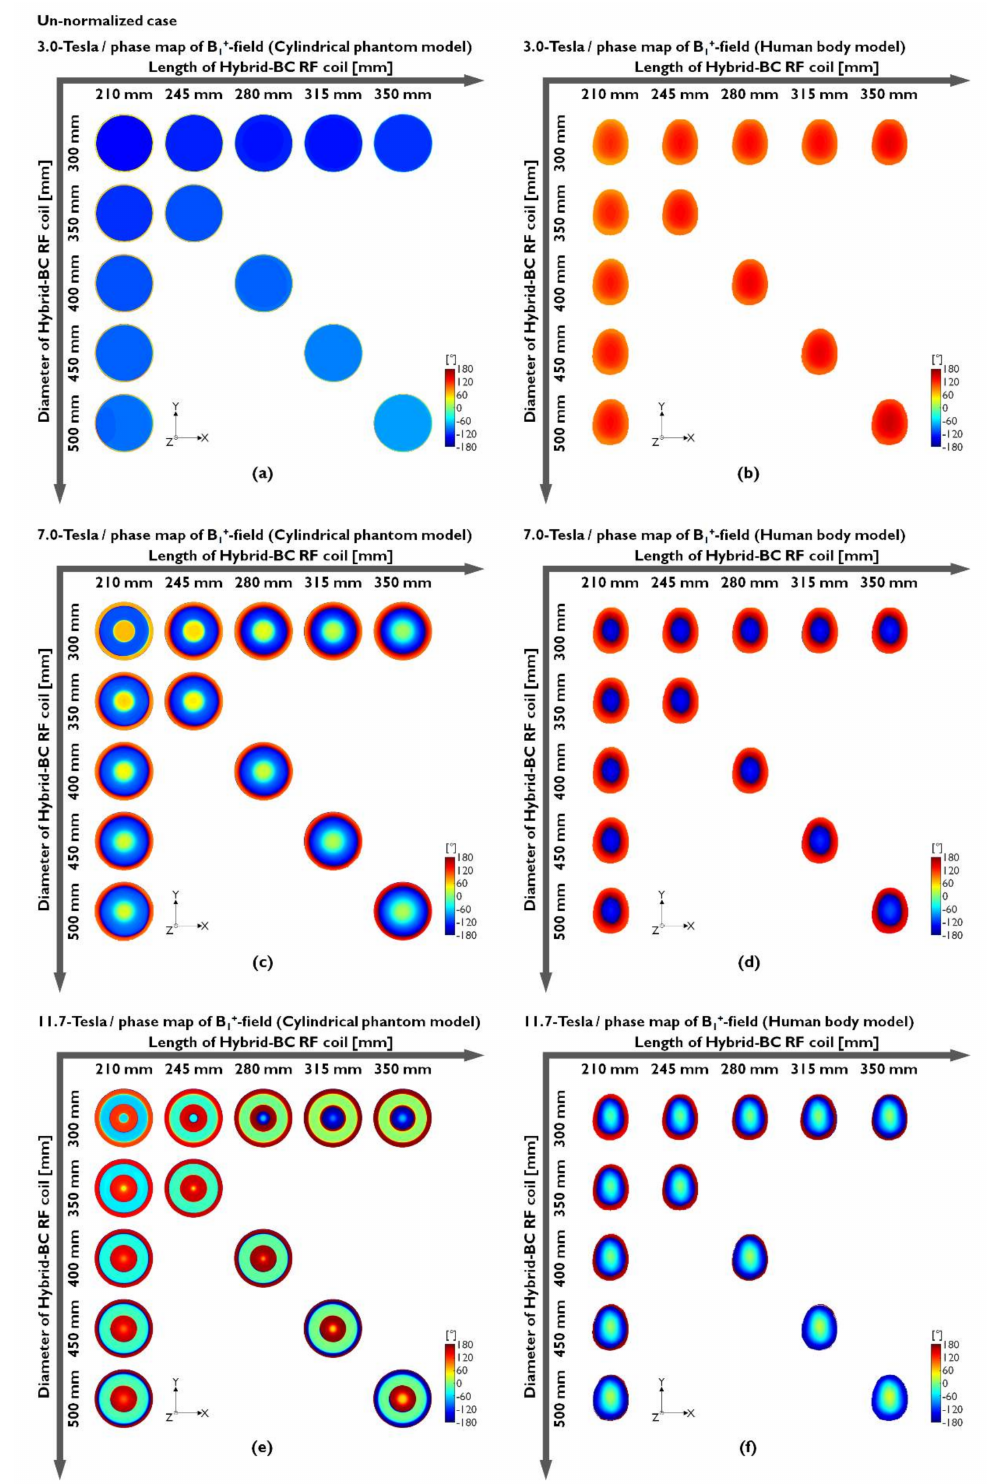
Figure 3. Phase map of the unnormalized B 1 + -field distribution obtained when using a cylindrical phantom model ( a , c , e ) or a human body model ( b , d , f